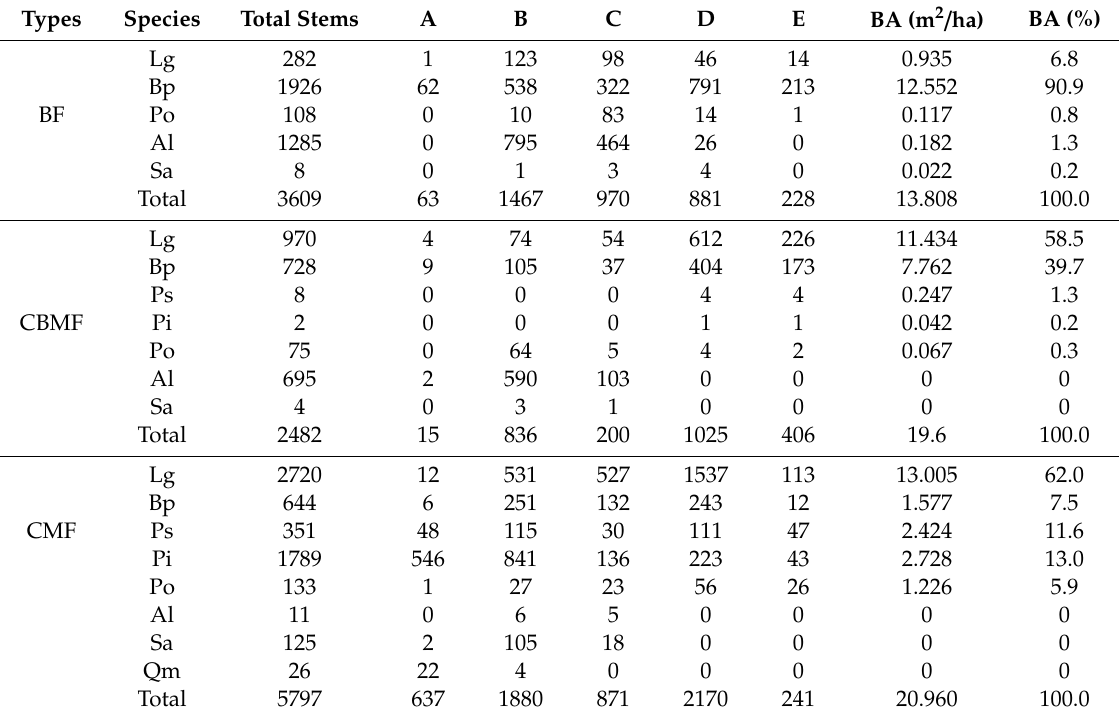
Table 1. Number of species and basal area in the three forest